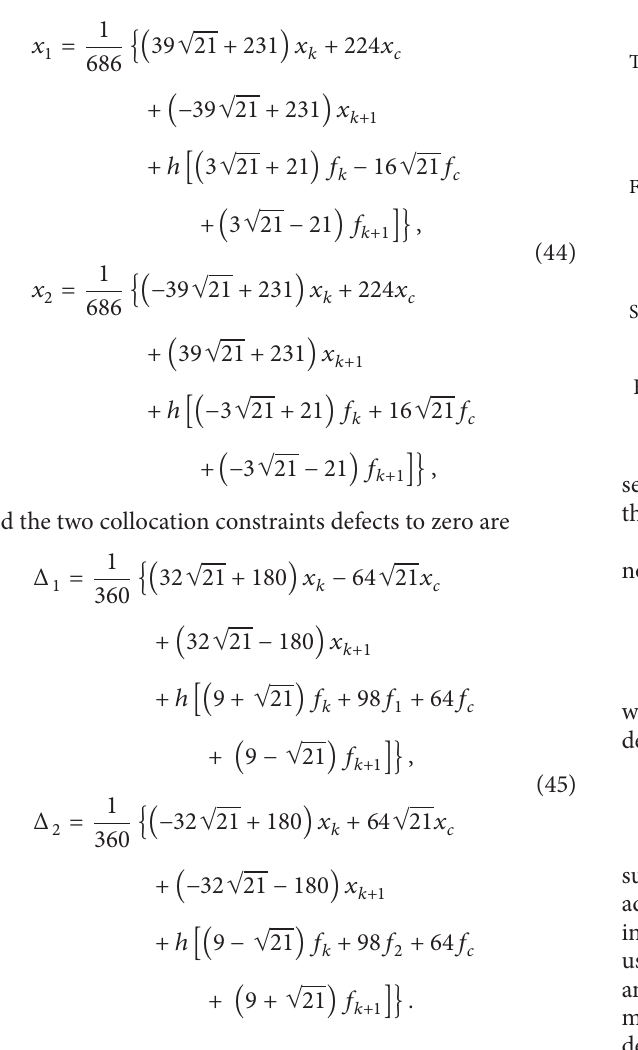
Figure 2: Fifth-order Gauss-Lobatto constraint formulation.